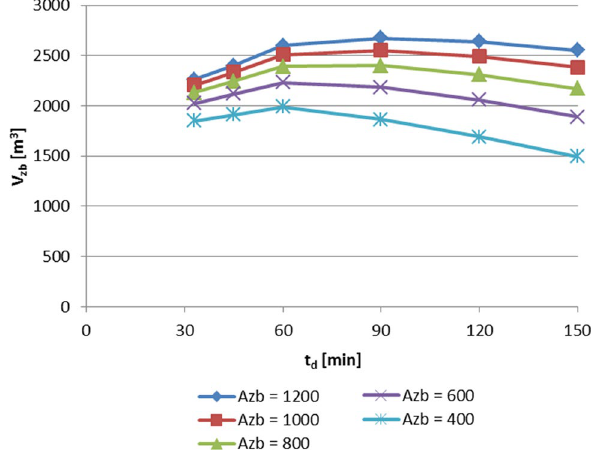
Fig. 6 Volume of storm water accumulated in the tank V tion of the storm duration t d and the bottom surface area A zb of the tank expressed in m